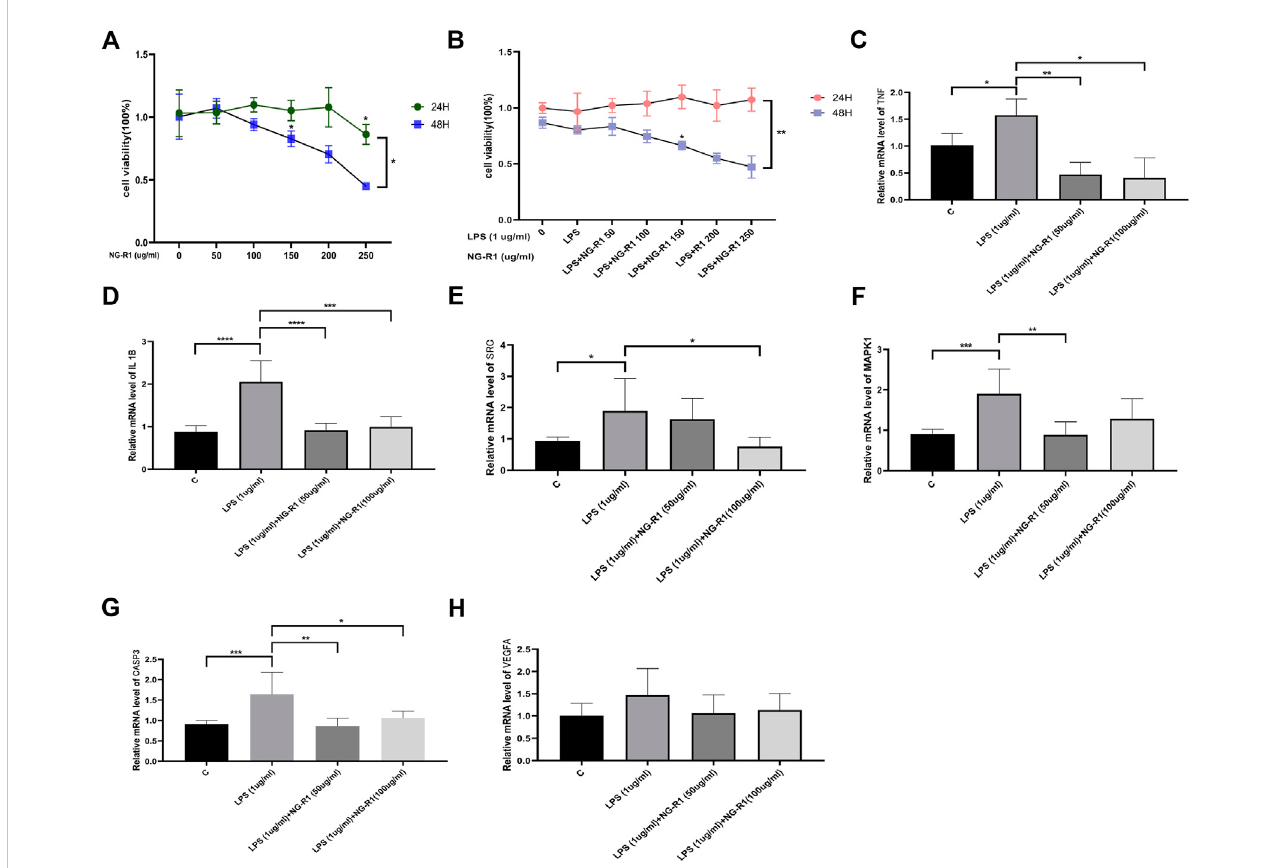
FIGURE 6 AC16 human cardiomyocytes were validated in vitro . (A) The effect of different NG-R1 concentrations (0, 50, 100, 150, 200, and 250 ug/ml) on the viability of AC16 cardiomyocytes over time (24 and 48 h), ( n = 3 per group). (B) Effect of different concentrations of NG-R1 (0, 50, 100, 150, 200, 250 ug/ml) andLPS(1ug/ml)ontheviabilityofAC16cardiomyocytesafterco-incubationfordifferenttimes(24hand48 h)( n =3pergroup). (C – H) Analysisofchangesin theexpressionofcoregenesTNF,IL1B,SRC,MAPK1andCASP3transcriptlevelsafterLPS,NG-R1intervention( n =3pergroup).Thedataarerepresented as means ± SD; * p < 0.05, ** p < 0.01, *** p < 0.001, **** p <